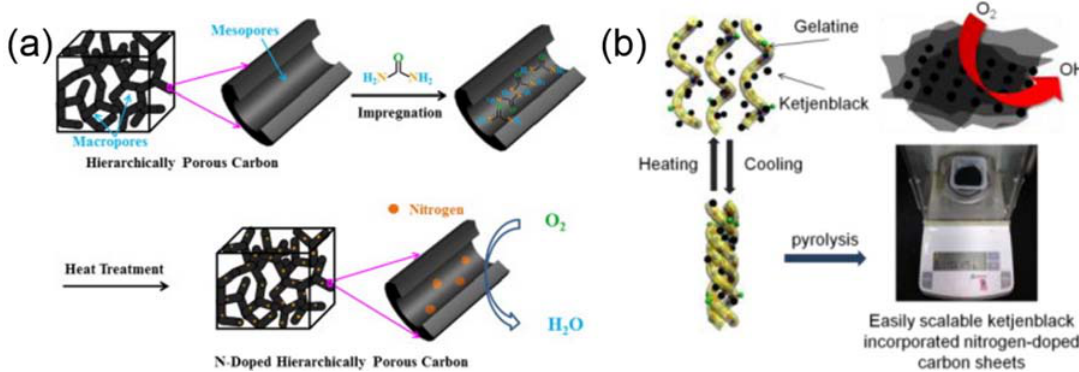
Figure 1. Schematic preparation of N ‐ doped metal ‐ free carbon ‐ based nanocatalysts using urea as N source ( a ) [50] Copyright 2015 Elsevier and pyrolysis of N ‐ containing precursor ( b ) [58]. Copyright 2014 American Chemical Society.